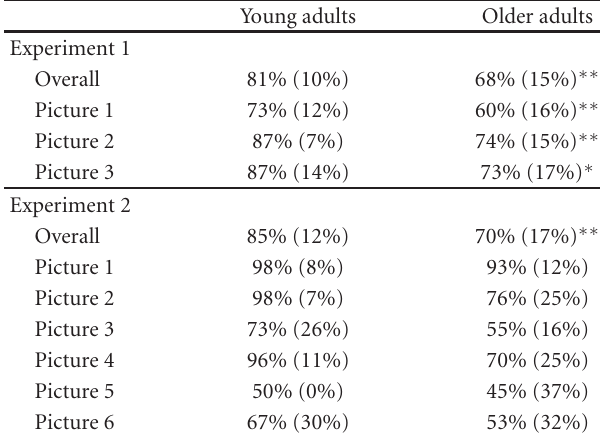
Table 2: Percent of errors detected, overall and separately for each stimulus picture in Experiments 1 and 2 (SDs in